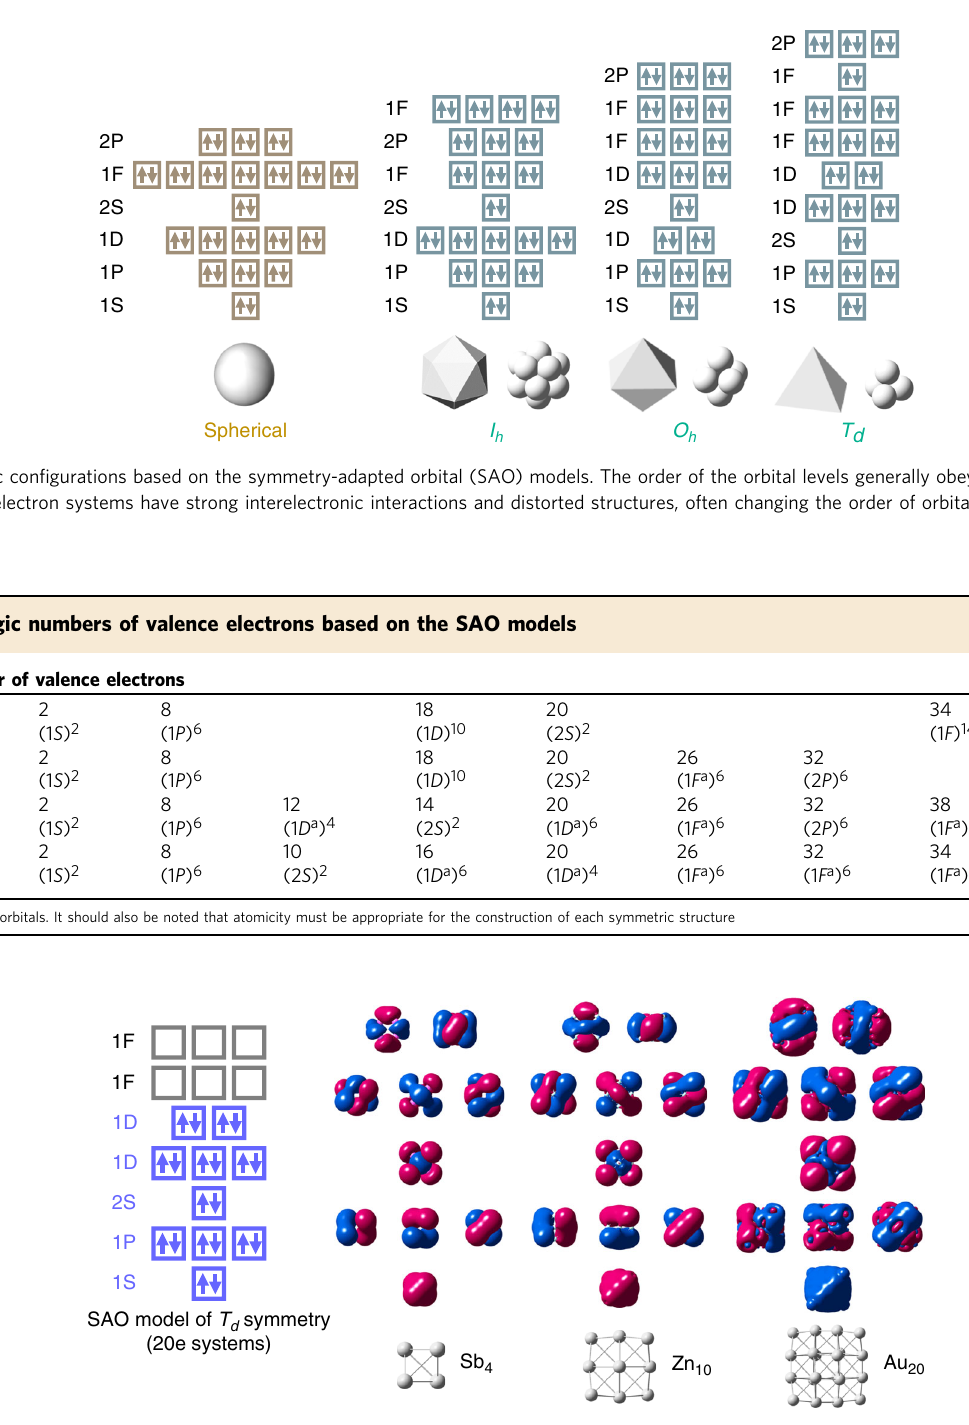
Fig. 2 Molecular orbitals of T d -type clusters. They can be ascribed to the split superatomic orbitals, depending on the orbital angular